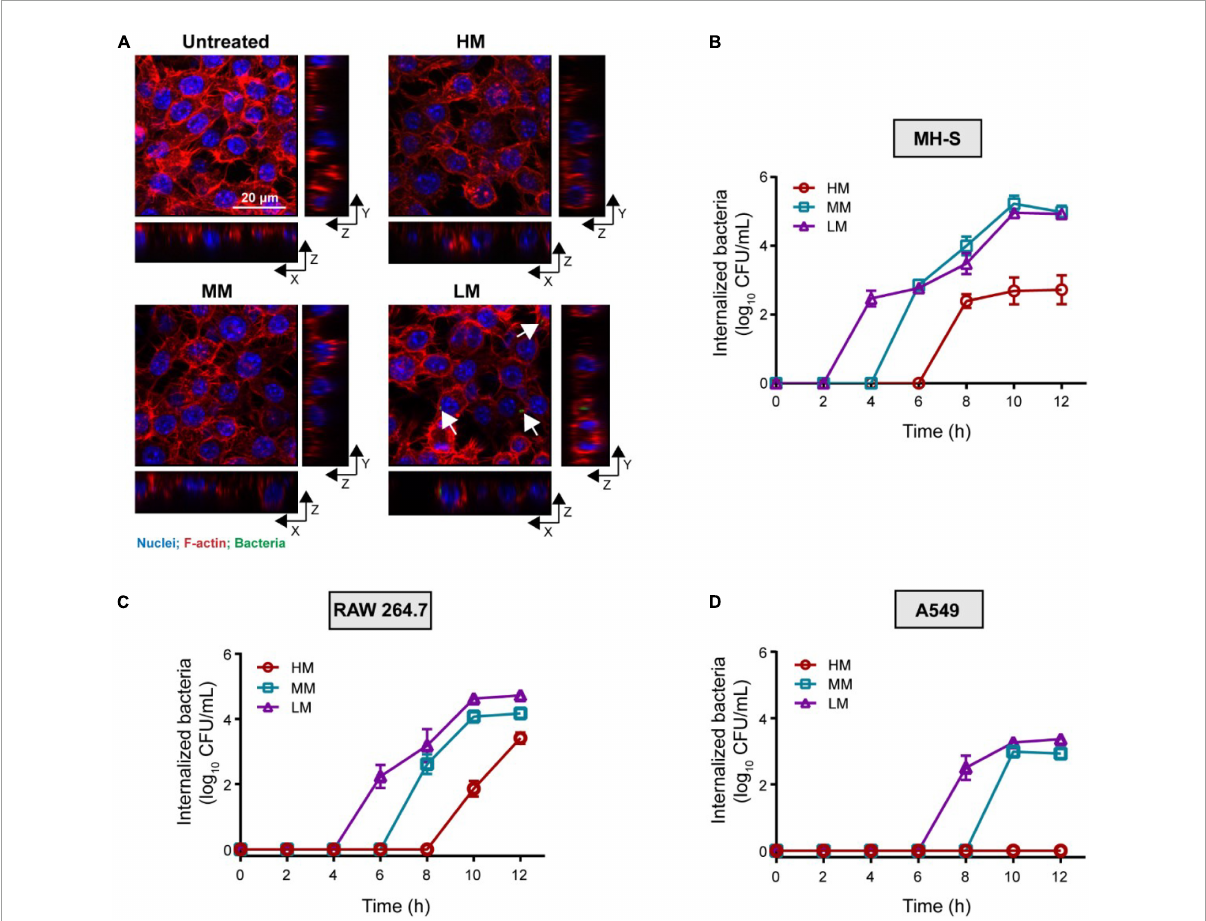
FIGURE3 Hypermucoviscous A. baumannii shows anti-phagocytic phenotype. (A) Internalized A. baumannii in macrophages. MH-S cells are infected with A. baumannii (MOI = 10) for 4 h. Bacteria were labeled with pHrodo (green). F-actin and nuclei were labeled with rhodamine phalloidin (red) and DAPI (blue), respectively. Scale bar = 20 µ m. (B–D) Viable counts of the internalized A. baumannii in MH-S cells (B) , RAW 264.7 (C) , and A549 cells (D) , infected with mucoid A. baumannii at MOI of 10 for 2–12 h. All experiments were performed as three biologically independent experiments, and the mean ± SD was